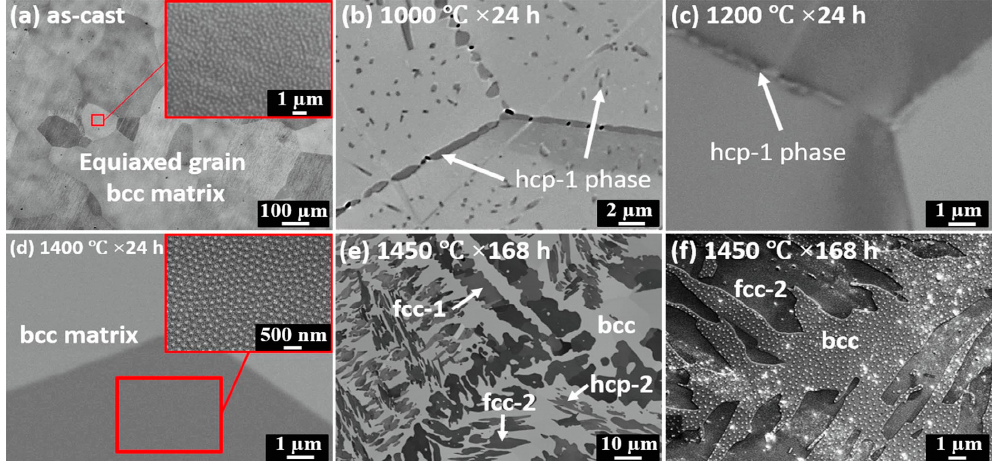
Figure 10. Microstructure evolution of HfNbTaTiZr RHEA at various conditions: ( a ) as-cast; ( b ) 1000 °C, 24 h; ( c ) 1200 °C, 24 h; ( d ) 1400 °C, 24 h; ( e ) 1450 °C, 168 h; ( f ) a magnified image of observed precipitates in condition of 1450 °C, 168 h. Reprinted with permission from Ref. [67]. Copyright 2019 Elsevier.